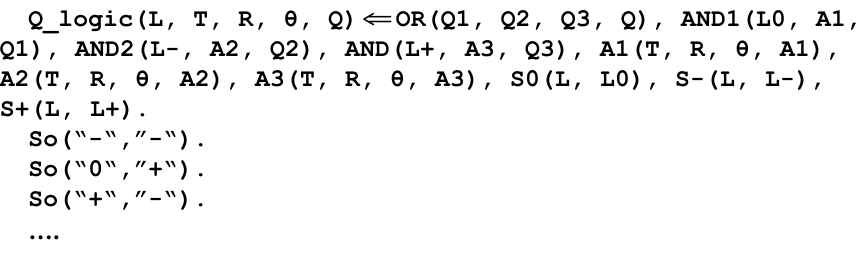
Fig. 11. Fragment of the Prolog program for the logical conclusion about the quality of given